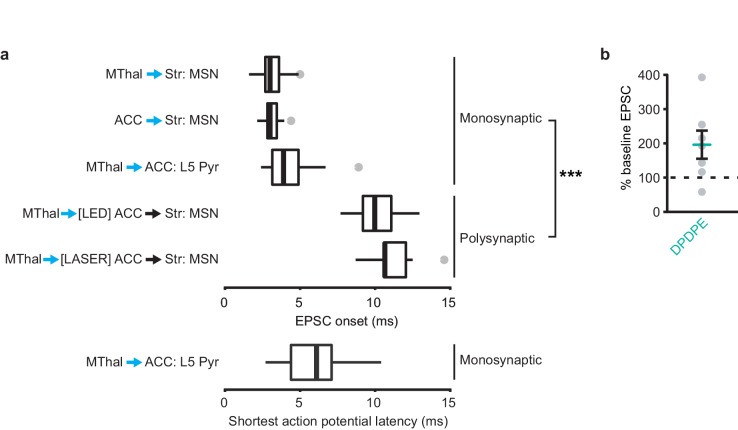
EPSCs and action potential latencies within the thalamo-cortico-striatal circuits.(a) Average onset time for monosynaptic and polysynaptic EPSCs using either full field (LED stimulation: all monosynaptic data, and [LED] ACC polysynaptic data), or focal (laser stimulation: [LASER] ACC polysynaptic data) optical stimulation. Mann-Whitney U test, U = 15, p<0.001. ***p≤0.001. Box plot with median, 1st and 3rd quartile and whiskers represent 1.5 times interquartile range. Lower panel: average of shortest action potential onset latency in L5 pyramidal neurons following stimulation of MThal terminals. Stimulation intensity was set to elicit ~50% spike probability out of 50 trials. (b) EPSC amplitudes measured in MSNs in the striatum (Str) evoked by optical stimulation of MThal terminals in the ACC in the presence of DPDPE, plotted as a percentage of baseline EPSC. N = 6, n = 7, paired Wilcoxon signed-rank test, W(7) = 3, p=0.078. Mean ± standard error of the mean.